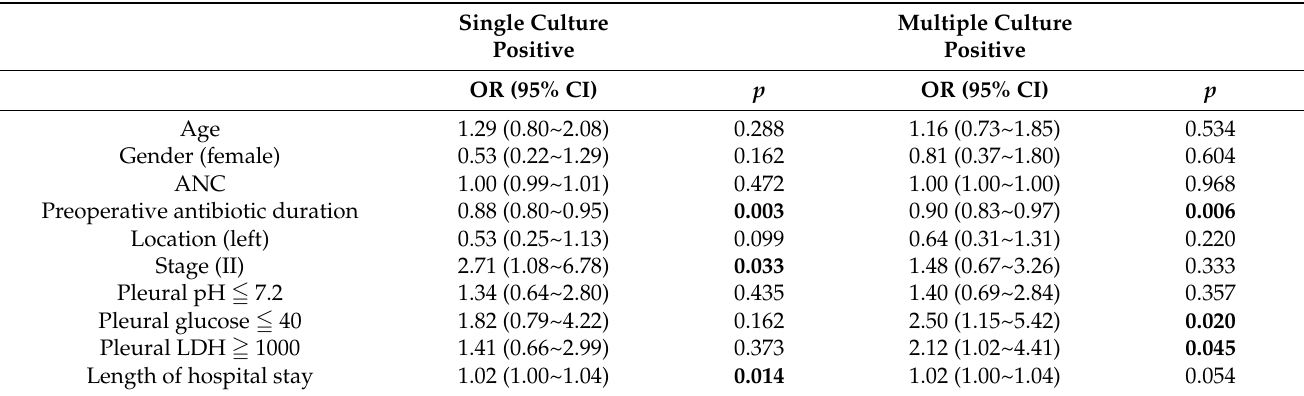
Table 3. Factors to predict the combined results of three types of cultures (pleural peels tissue, pleural fluid, and